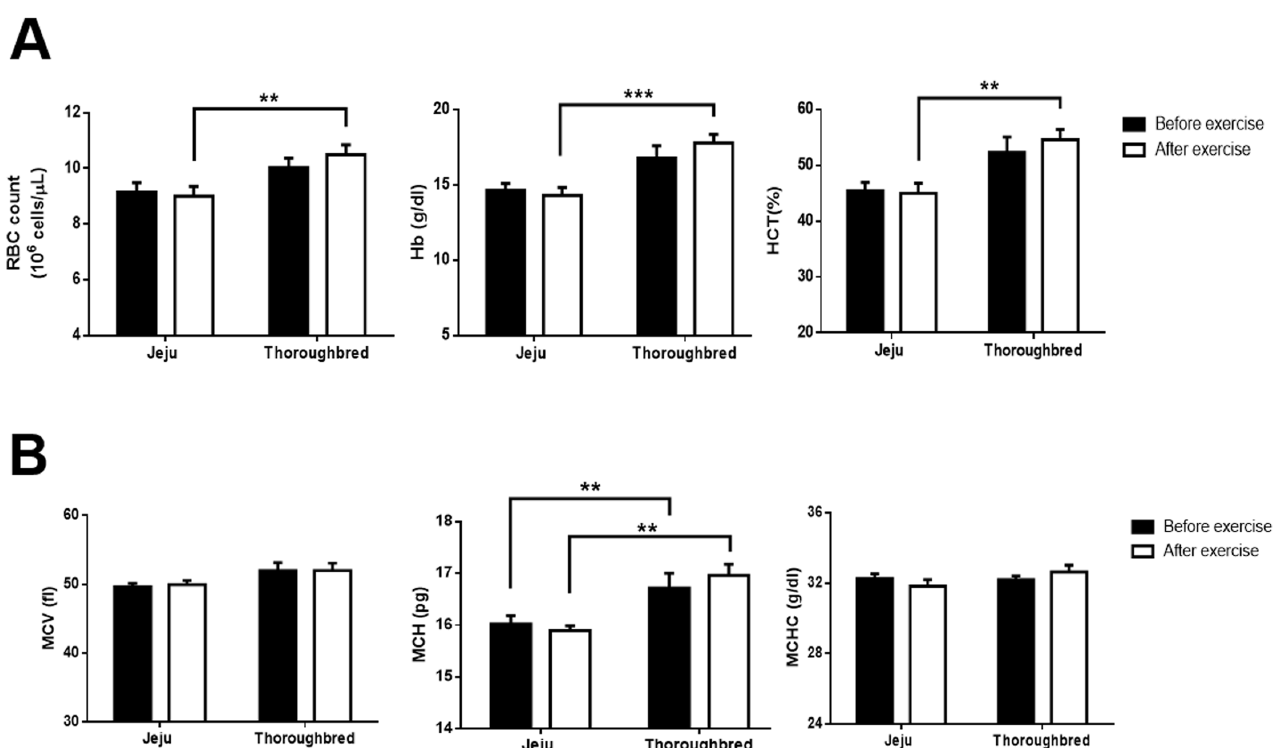
Figure 2. Significant increase in red blood cell indices after 30 min of exercise in Thoroughbred horses. Jeju and Thoroughbred horses were exercised for 30 min. Blood was collected before and after exercise to analyze red blood cell indices, namely, red blood cell (RBC) count, hemoglobin (Hb), hematocrit (Hct), mean corpuscular volume (MCV), mean corpuscular hemoglobin (MCH), and mean corpuscular hemoglobin concentration (MCHC). (A) RBC count, Hb, and Hct data. (B) MCV, MCH, and MCHC data. Black and white circles represent data from before and after exercise, respectively (n = 5 for each breed; * p<0.05, ** p<0.01, and *** p<0.001, unpaired Student’s